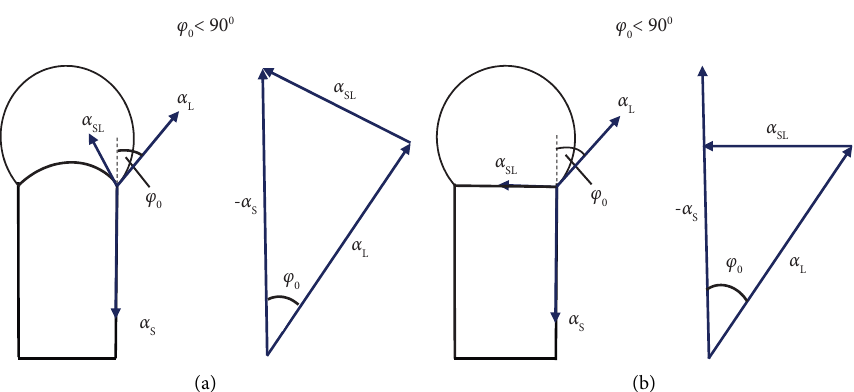
Figure 11: Vector diagram of forces corresponding to the specifc free energies of the three-phase interfaces for the NWs growth with a nonsingular end surface (a) and a singular transverse facet (b).